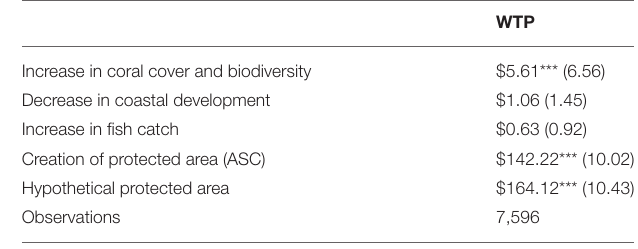
TABLE 2 | Estimation results of the main effects models. TABLE 3 | Willingness to pay (WTP) for a coral reef conservation